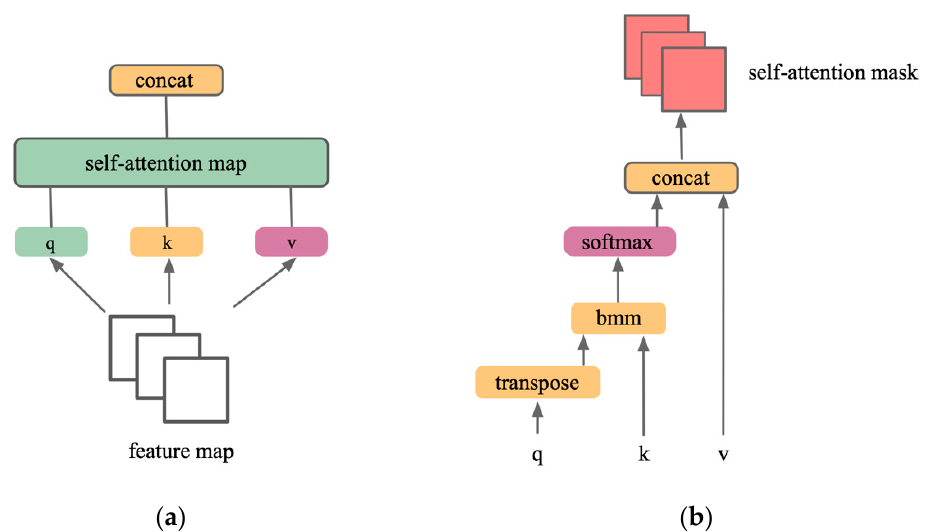
Figure 2. An illustration of a self-attention network. ( a ) SAN’s inputs are three space vectors from feature maps. ( b ) Detail of self-attention map building process. The output of the SAN is a mask which will reweight the original feature maps.